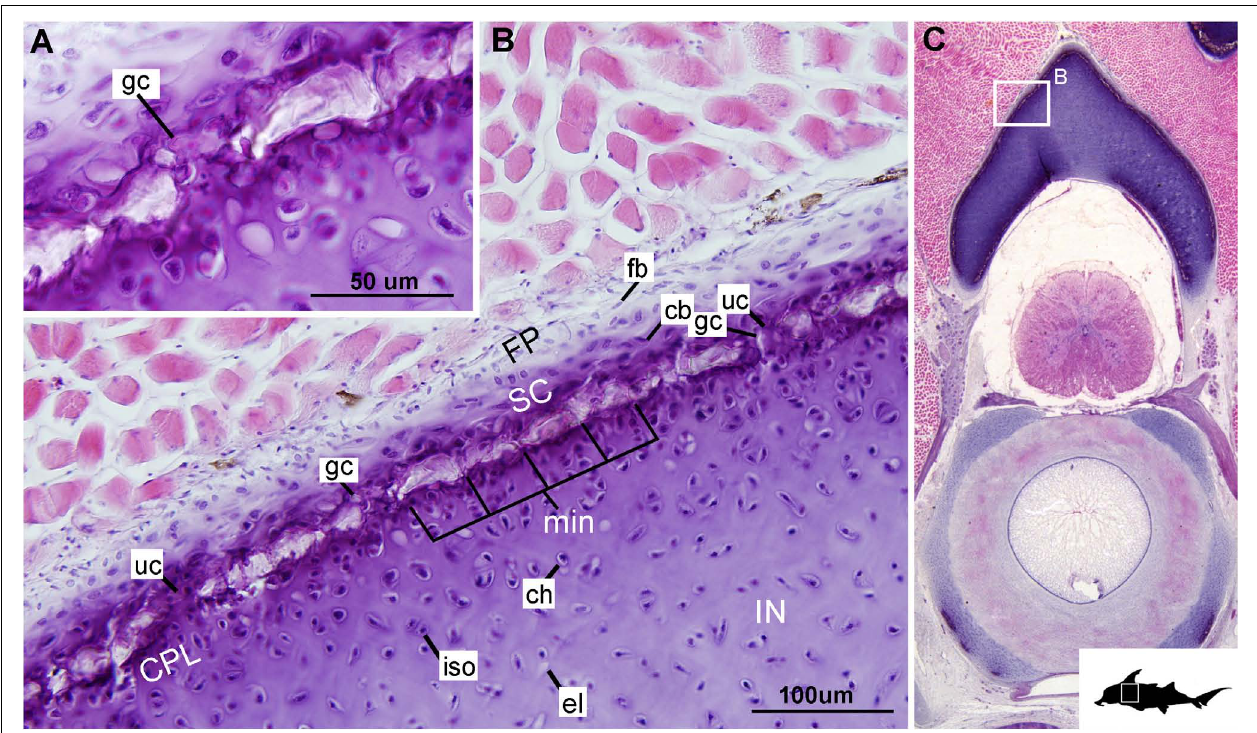
FIGURE 6 | Histological section through the synarcual (anterior fused vertebrae) of a stage 36 embryo of Callorhinchus milii (Holocephali; Callorhinchidae). (A,B) Closeups showing the potential formation of new mineralization foci between already existing units; (C) overview of section through the neural arch with locations of closeup views indicated by white squares. Abbreviations: as in previous figures. Black silhouette of C. millii indicates approximate region shown in the